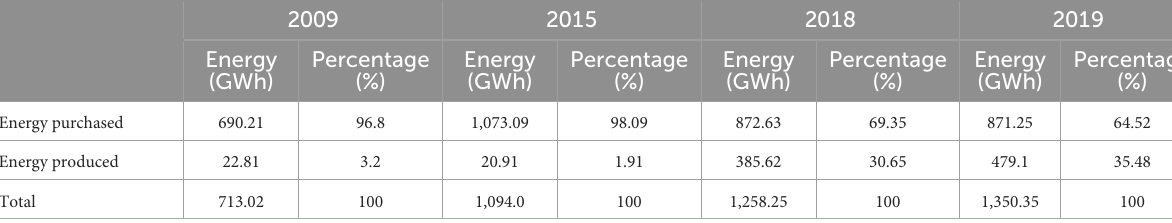
TABLE 6 Estimation of energy purchased and production for the years 2009, 2018, and 2019.